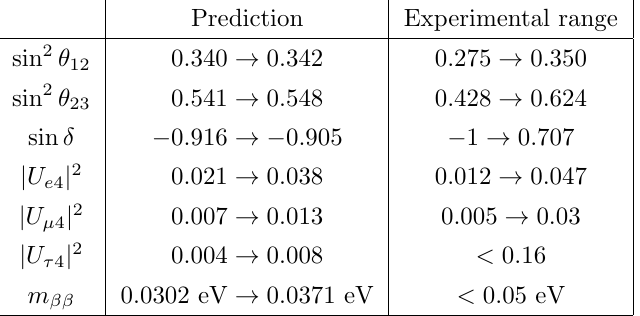
Table 4 . The values of the observables predicted by the model in comparison to their experi- mental ranges [73, 74, 77]. m (cid:12)(cid:12) < 0 : 05 eV is the most stringent bound from the KamLAND-Zen experiment